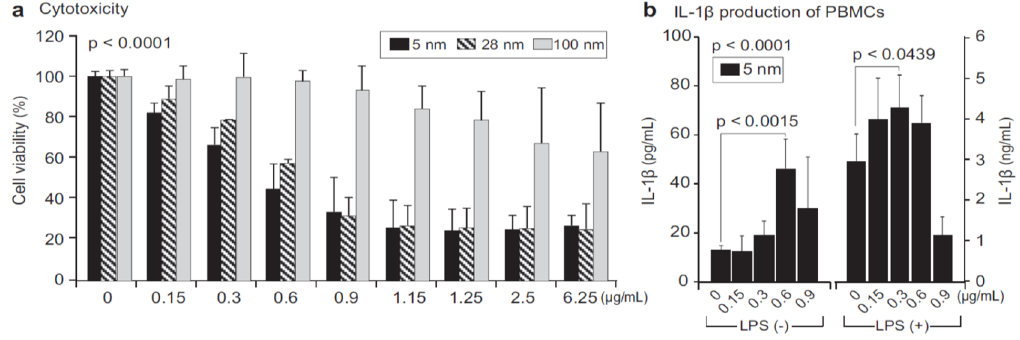
Figure 24. Cytotoxicity and IL-1 β generation in PBMCs. ( a ) PBMCs were treated with AgNPs for 6 h and cell viability was determined with CCK-8 assay. ( b ) PBMCs were treated with AgNPs (5 nm) for 6 h and supernatant levels of IL-1 β were assessed by ELISA. LPS (50 pg/mL) was pre-treated for 2 h before AgNPs exposure. Results were presented as means ± SD. One-way ANOVA analysis showed significance ( p < 0.0001) ( a , b ), and Student’s t -test between certain pairs ( b ) was used for statistical analysis. Reproduced from [216] with permission of Elsevier.